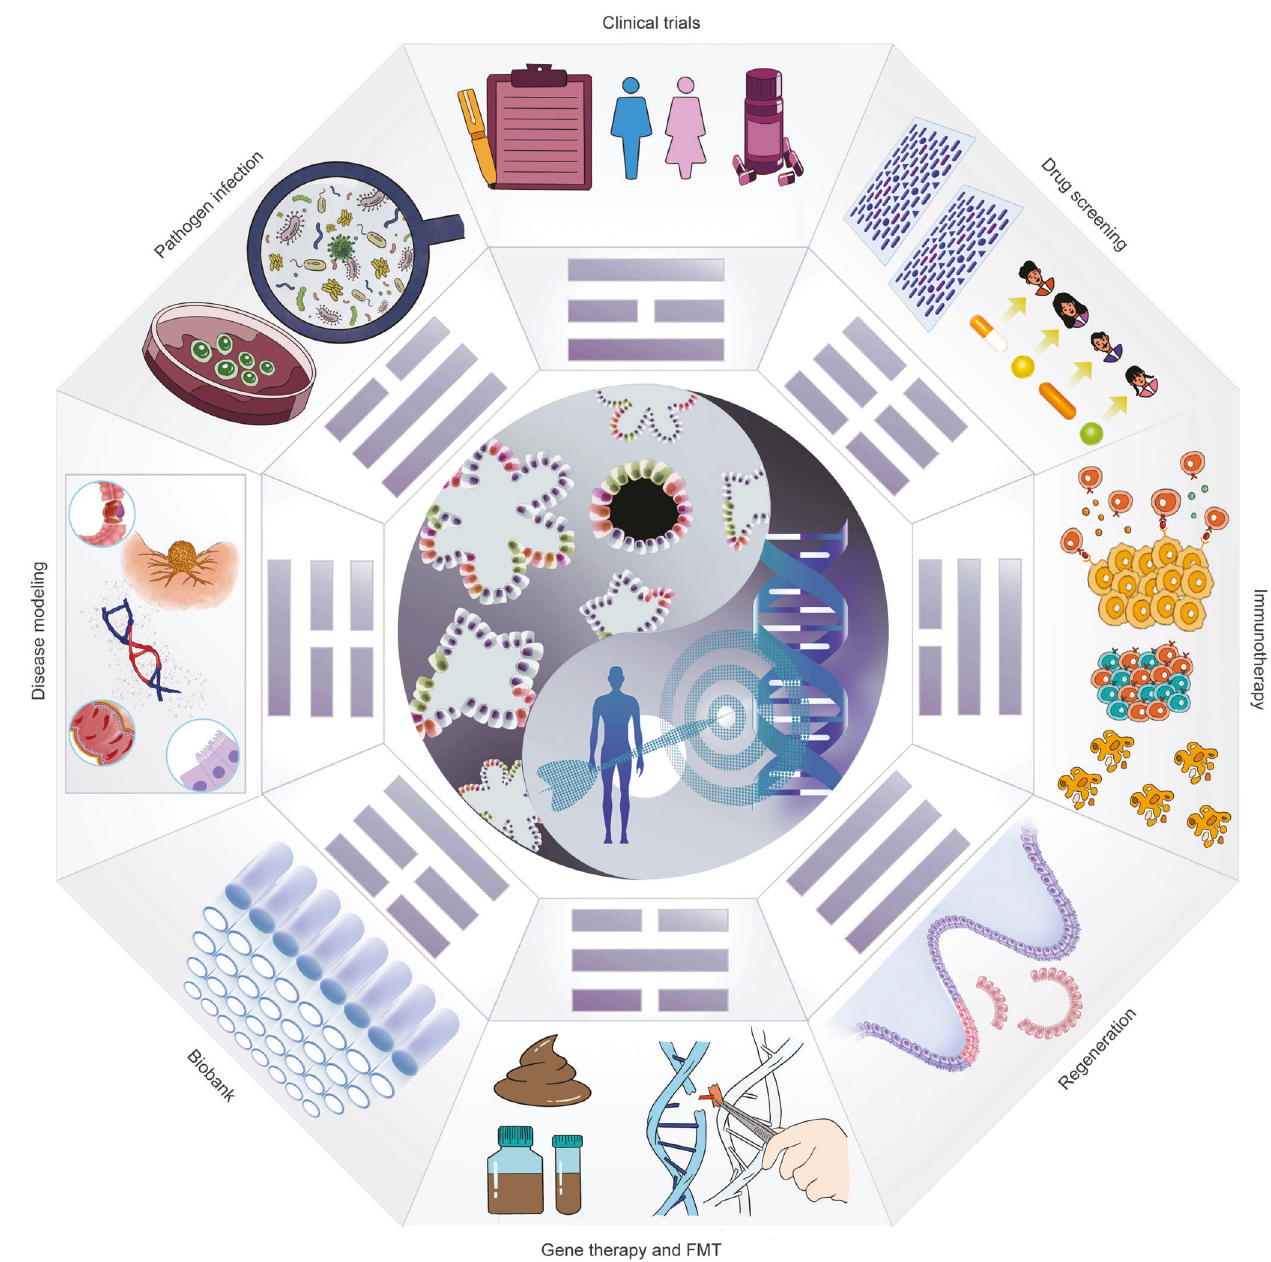
Fig. 2 Potential applications of organoid models in precision medicine. As a versatile in vitro model, organoids can cover many applications from disease modeling to clinical trials and achieve the purpose of precise and personalized treatment. The scope of organoid research includes (1) Disease modeling. (2) Pathogenic infection. (3) Biobanking of organoids. (4) Clinical trials. (5) Stem cell function and regeneration (delivery of organoids to repair intestinal epithelium or activate the repair program of endogenous stem cells). (6) Drug screening (patient- speci fi c high-throughput screening and discovery). (7) Immunotherapy. (8) Gene therapy and